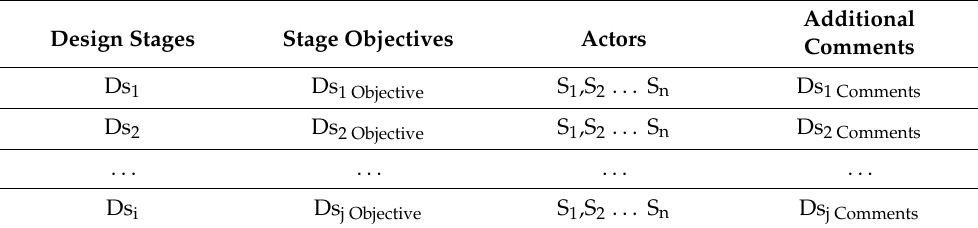
Table 3. Generic data screening matrix for information collection [22].